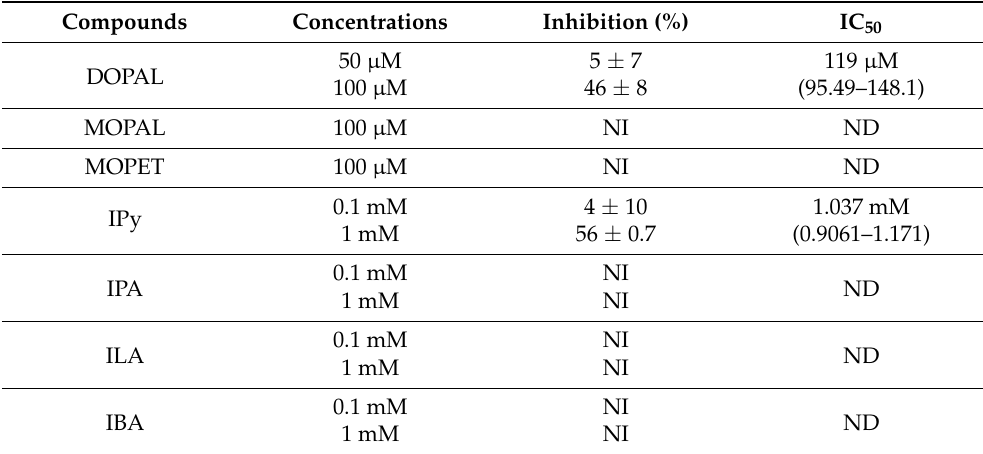
Table 1. Inhibition of VEGF-induced VEGFR-2 phosphorylation and IC 50 values of HT metabolites and indolic